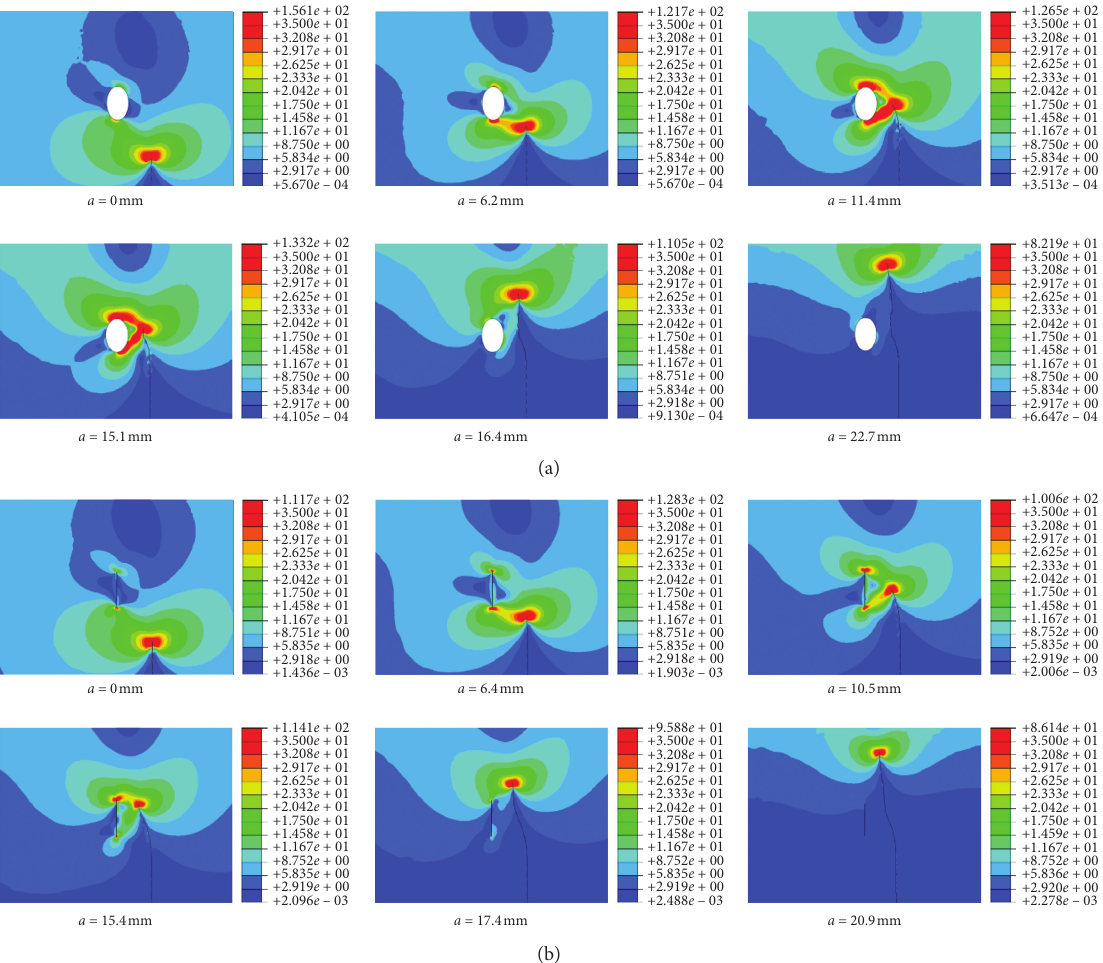
Figure 12: von Mises stress field with different vertical distance of crack. (a) Specimen S